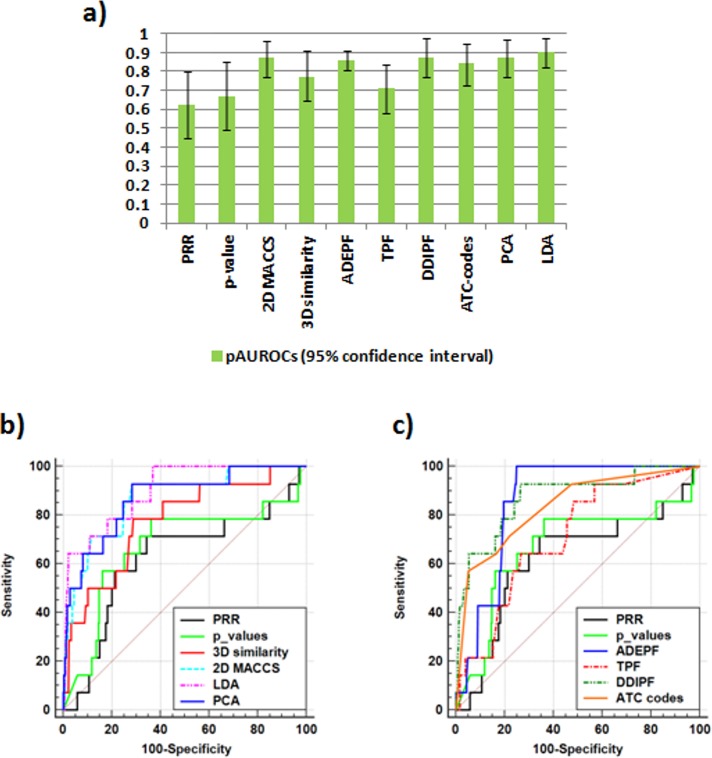
ROC results using different methods to rank the 386 TWOSIDES candidates: PRR (Proportional Reporting Ratio), p-values, 2D structural similarity (MACCS), 3D structural similarity, ADEPF (Adverse Drug Effect Profile Fingerprint), TPF (Target Profile Fingerprint), DDIPF (Drug-Drug Interaction Profile Fingerprint), ATC-code fingerprint, PCA (Principal Component Analysis) and LDA (Linear Discriminant Analysis).Panel (a) shows pAUROCs with 95% confidence intervals. Panels (b) and (c) show the ROC curves for the different methods.